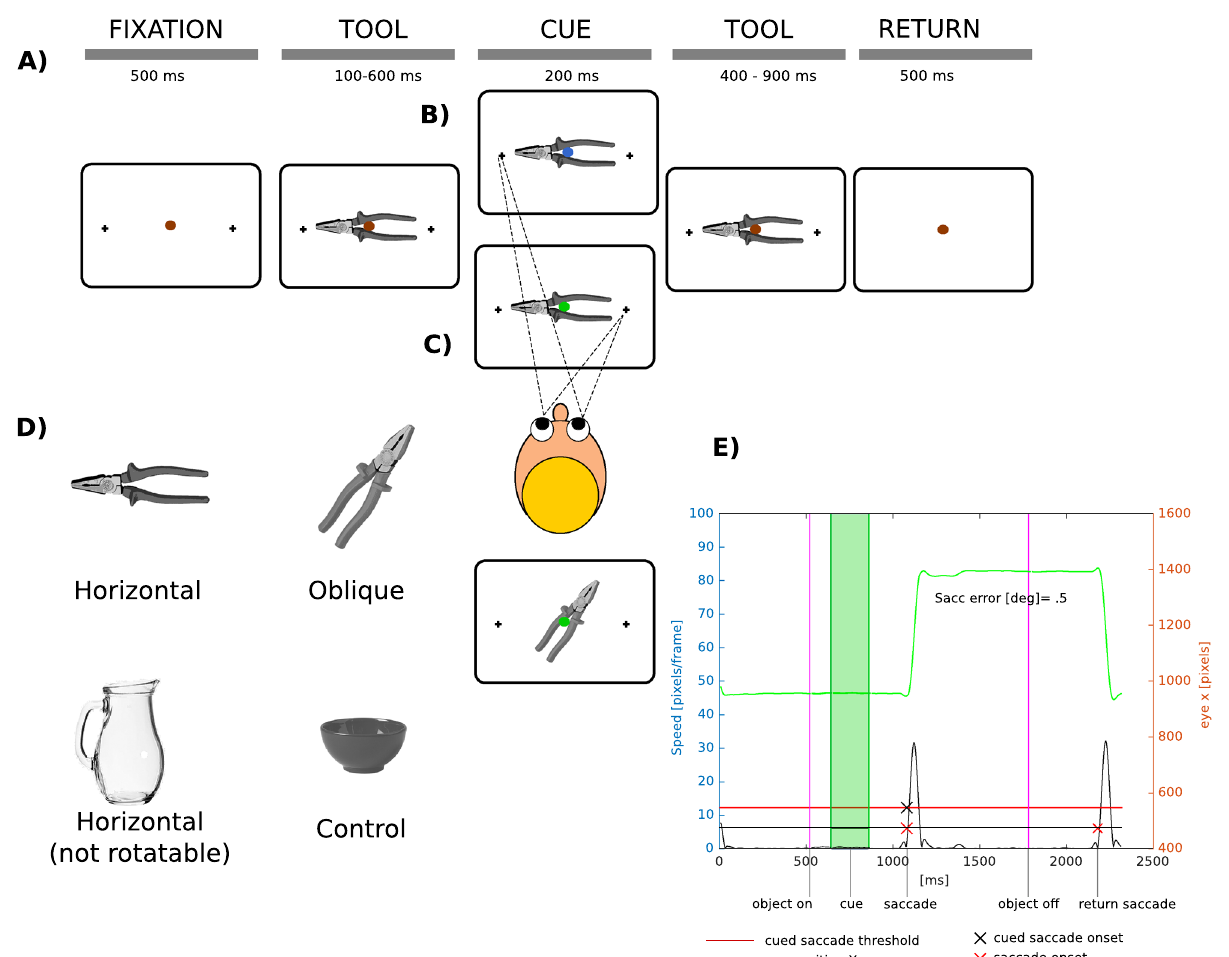
Figure 1. ( A ) Schematic depiction of a trial timeline for ( B ) head- and ( C ) handle-congruent saccades. See also Supplement 2 for an example timeline for oblique objects. ( D ) Example objects used in the experiment. ( E ) The saccade detection algorithm performance over an exemplary “green” trial timeline. The vertical bars denote epoch on/offsets (see labels), The green line is eye position X in screen coordinates plotted against time. Red crosses mark saccade onsets. Black cross denotes the onset of the saccade that was later taken for analysis. Figure created with Inkscape v. 0.92